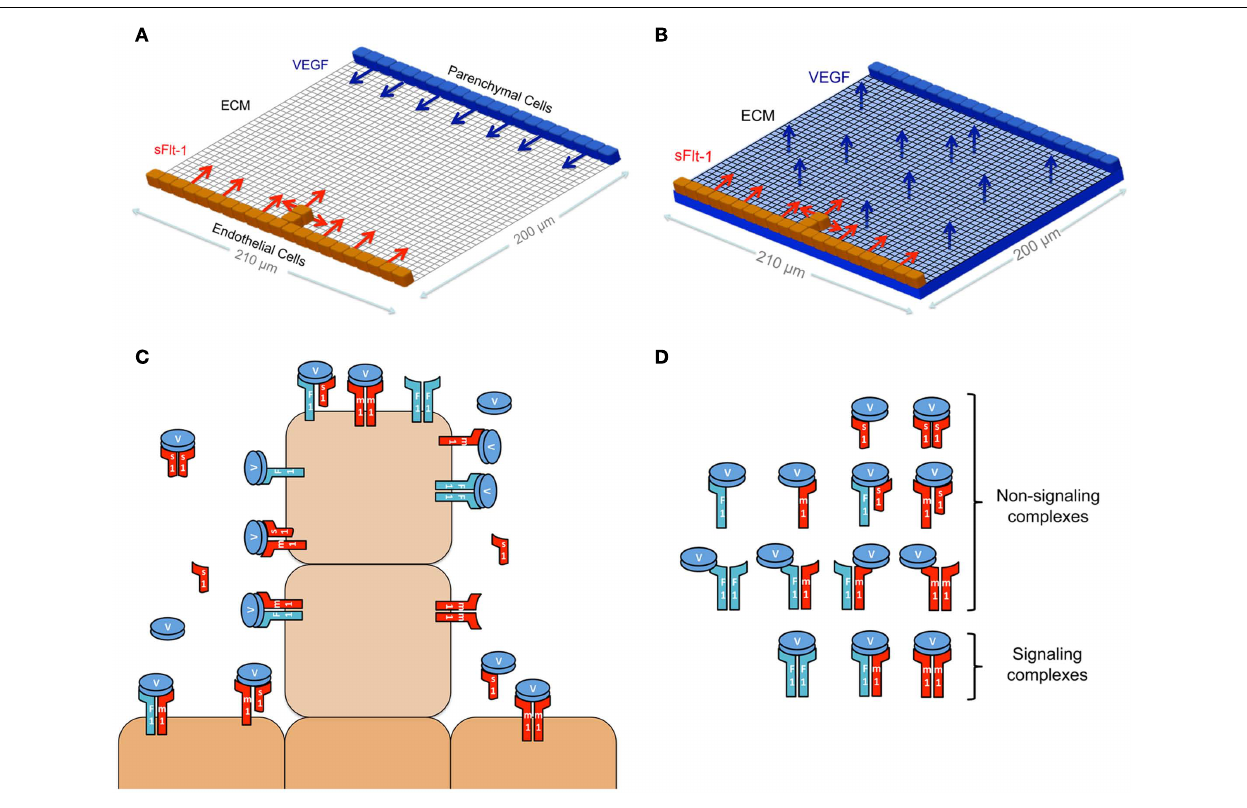
cases (A,B) are essentially 2-D models. (C) Schematic of the molecular species and the cell surface signaling and non-signaling receptor complexes. (D) Schematic showing non-signaling (top) and signaling (bottom) receptor